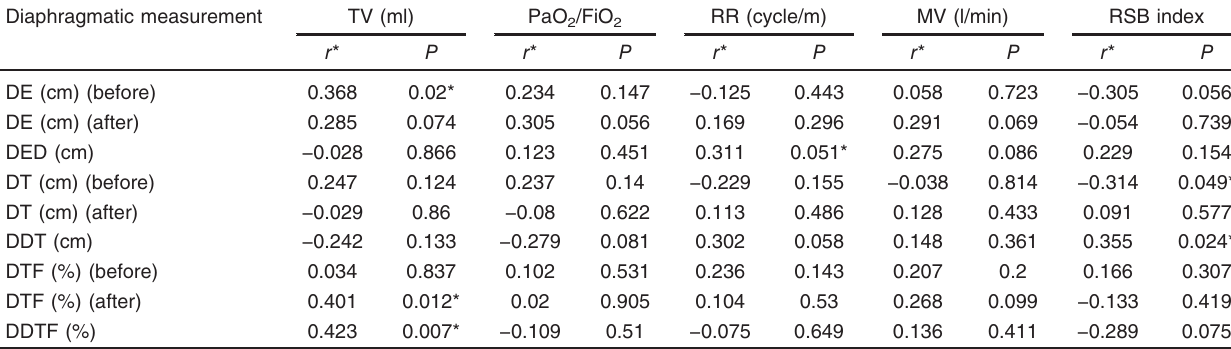
Table 4 Relation between criteria of weaning and the ultrasound diaphragmatic parameter before and after